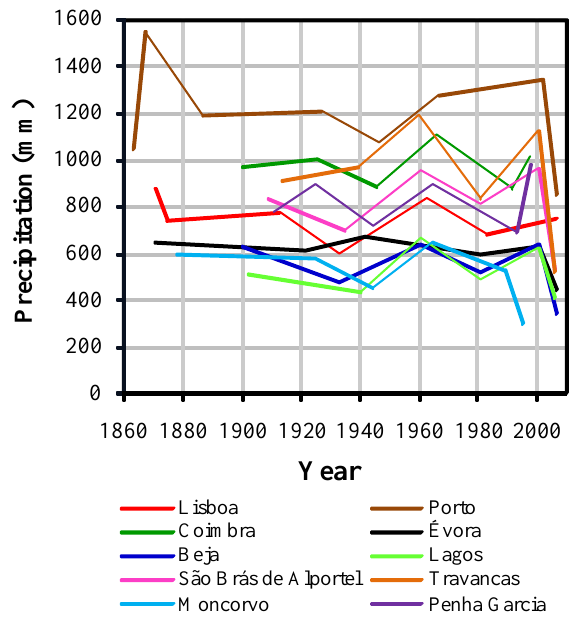
Fig. 4. Monthly precipitation trends in the common period 1960– 1980, which corresponds roughly to a period of decreasing annual Fig. 3. Partial trends in annual precipitation from mainland Portu- trend for most of the 10 locations Fig. 4 . Monthly precipitation trends in the common period 1960-1980, which corresponds gal. The breakpoints were estimated using the method proposed by Fig. 3 . Partial trends in annual precipitation from mainland Portugal. The breakpoints were Tom´e and Miranda (2005). The time series are not plotted. roughly to a period of decreasing annual trend for most of the 10 locations studied. estimated using the method proposed by Tomé and Miranda (2005). The time series are not plotted.